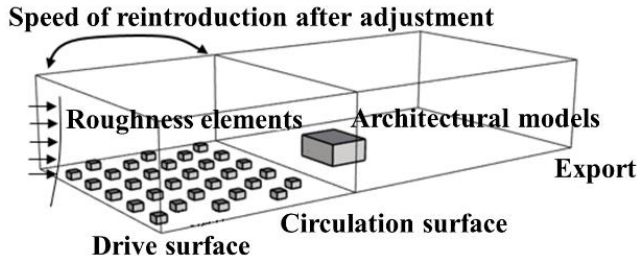
Figure 2. Schematic diagram of the cyclic pre-simulation method.